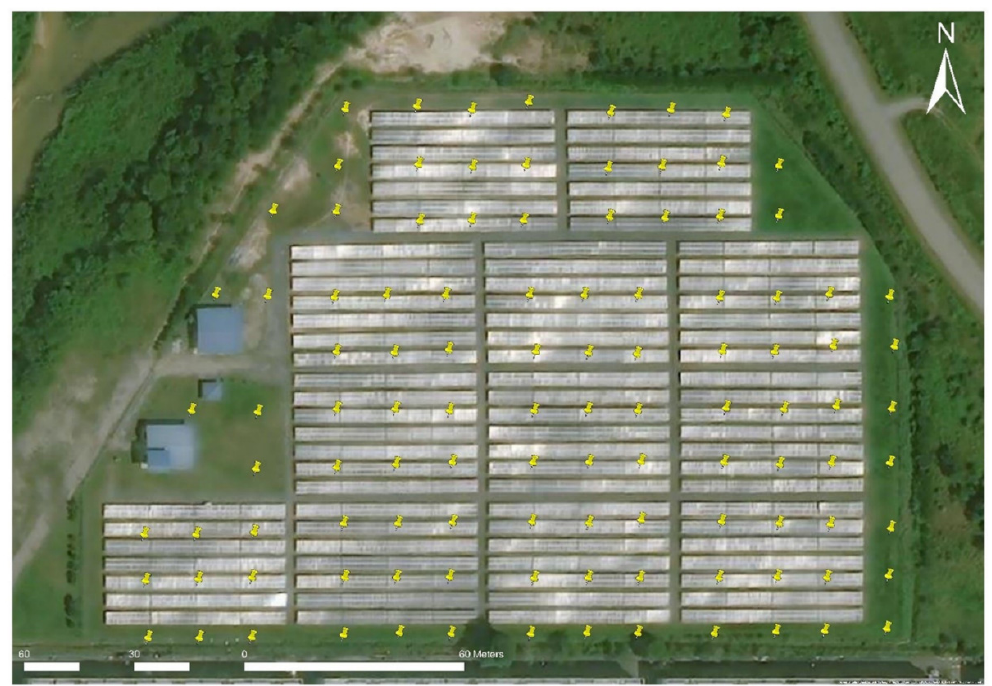
Figure 8. Quadrat sampling approach with 108 sampling points at the Puchong site. The collected field data were analyzed using GenStat Ver. 12 (VSN International Ltd.,